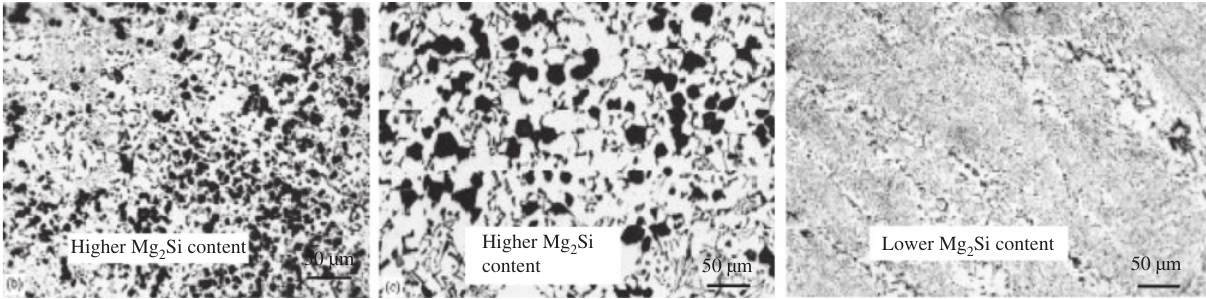
Si specimen: (A) inside the wall, (B) outside the wall, and (C) 2